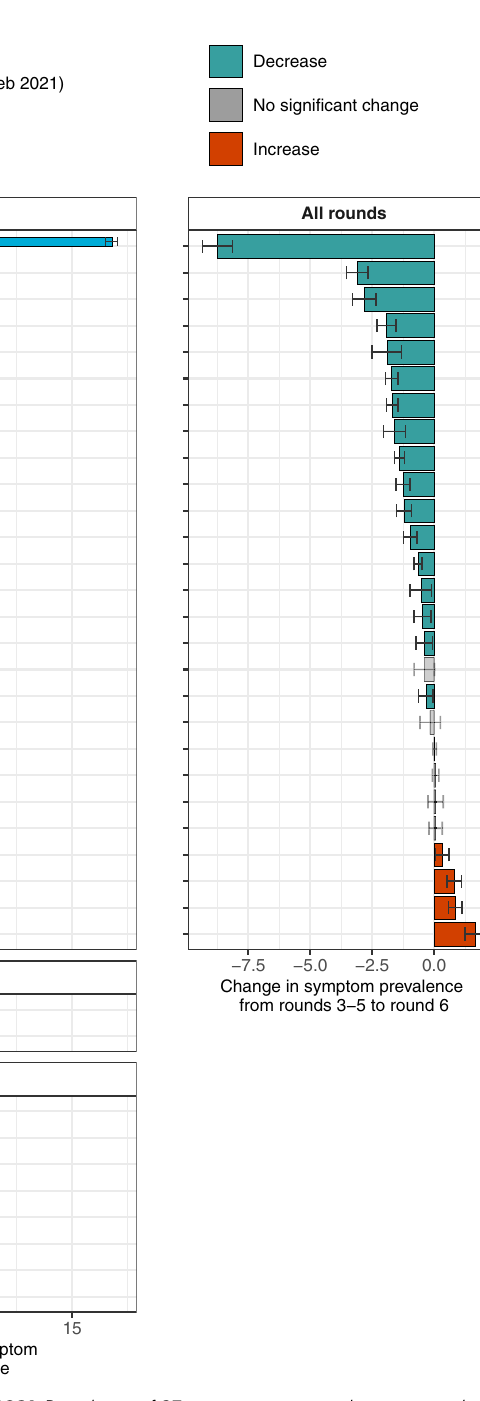
Cluster L1 at 27.4% (26.7,28.1). Rates of hospitalisation were